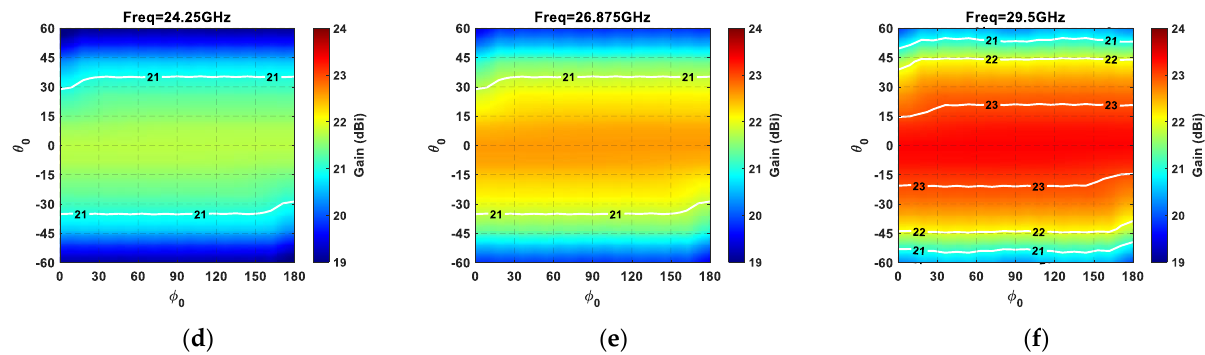
( d ) ( e ) ( f ) Figure 8. Gain in dBi of a planar array composed of 64 elements (8 × 8 array) as a function of the main beam steering inside the circular angular sector ( − 60 ◦ ≤ θ 0 ≤ 60 ◦ , 0 ◦ ≤ φ 0 ≤ 180 ◦ ). Equilateral triangular lattice at ( a ) 24.25 GHz, ( b ) 26.875 GHz, and ( c ) 29.5 GHz; square lattice at ( d ) 24.25 GHz, ( e ) 26.875 GHz, and ( f ) 29.5 GHz. Table 1. Statistical comparison between the gain (dBi) of a square lattice and an equilateral triangular lattice for an 8 × 8 array evaluated within the circular scan sector. 24.25 GHz 24.25 GHz 26.875